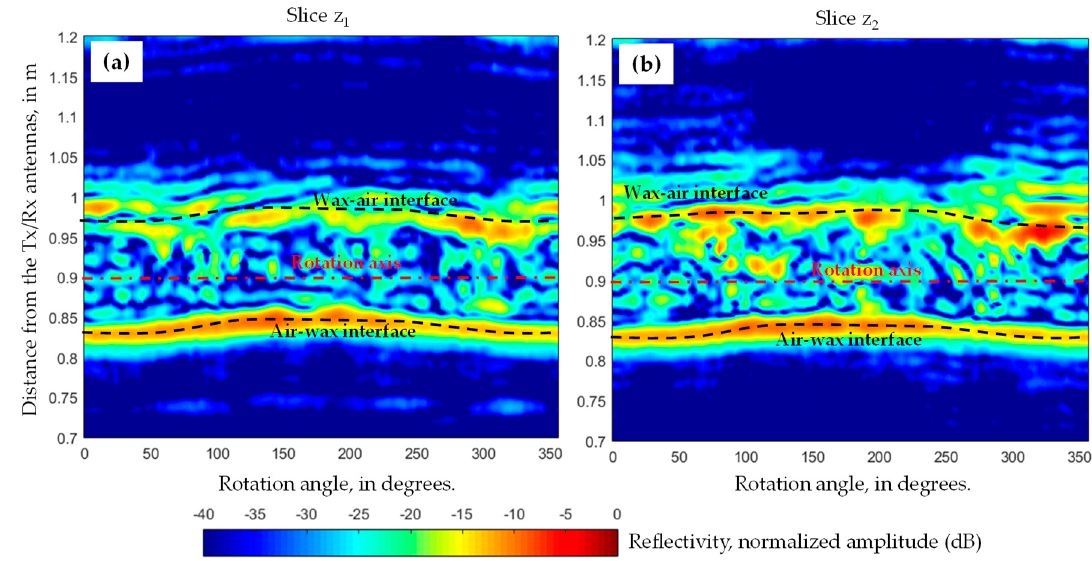
Figure 6. Reflectivity calculated for each observation angle as a function of the distance from the Tx/Rx antennas, for two different XY slices (( a ) z 1 = − 12 cm and ( b ) z 2 = − 5 cm with respect to the top of the wax candle). Air-wax (front reflection) and wax-air (rear reflection) interfaces are noticed.